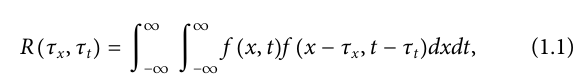
where f ( x , t ) is the grayscale value of the space-time image, ( τ x , τ t ) are the displacement parameters, R ( τ x , τ t ) is the two-dimensional